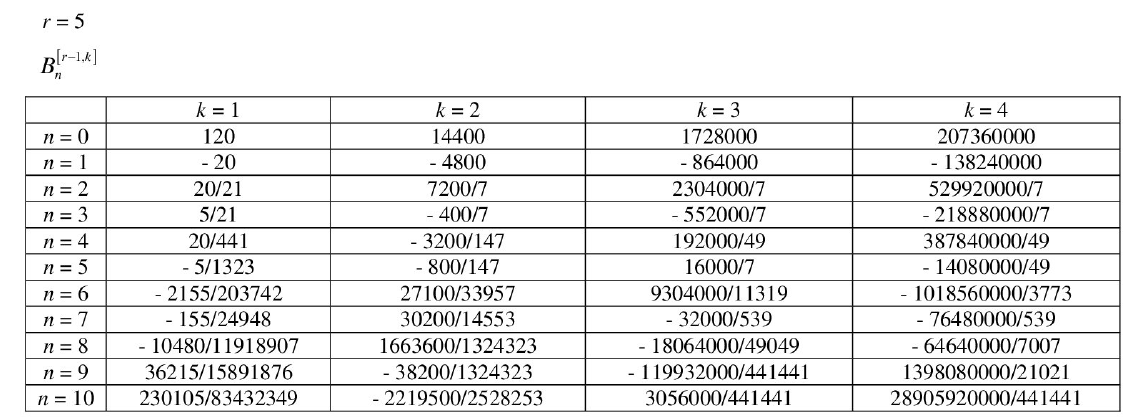
Figure 3. Numbers B